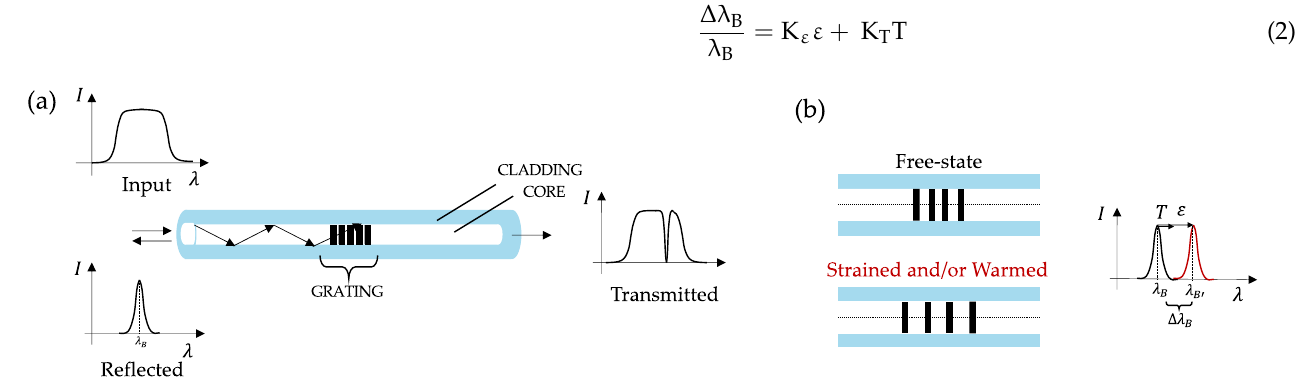
Figure 1. FBG working principle ( a ) and changes in its structure due to axial ε and T increments ( b ).